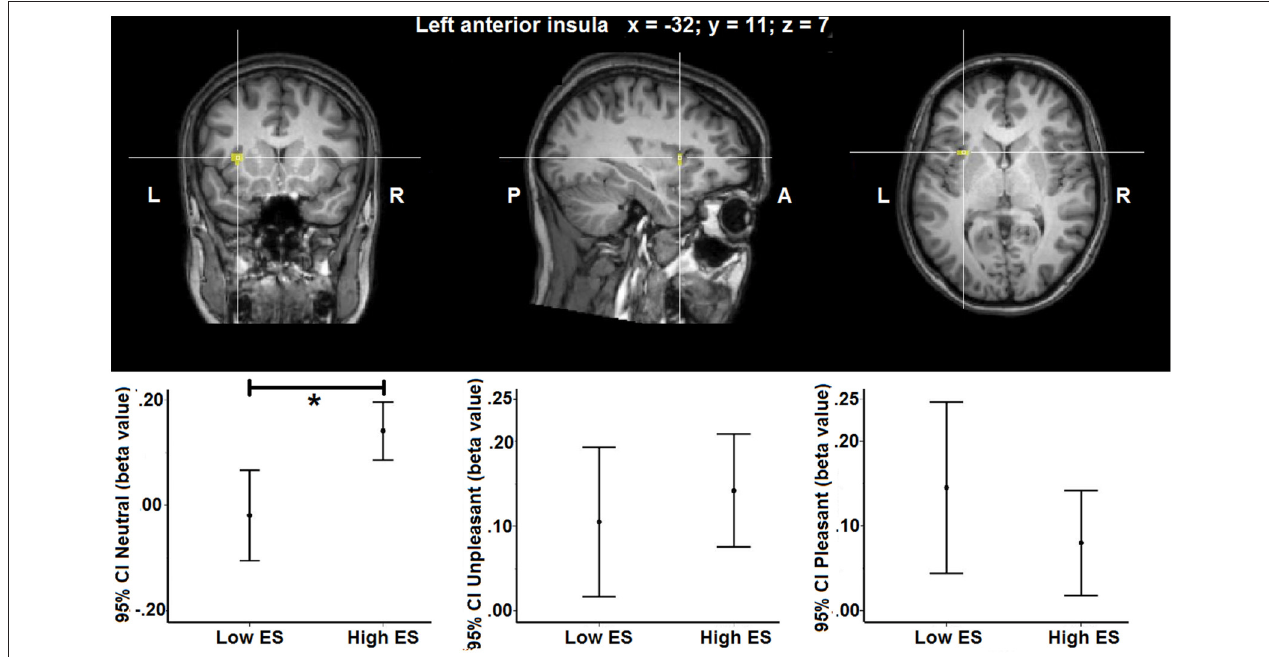
FIGURE 2 | Group statistical maps of the group (low ES, high ES) × experimental condition (unpleasant, pleasant, neutral) interaction effect showing a statistically significant cluster in left anterior insula [ F (2 , 46) > 10.44, p > 0.05 corrected]. Graphs show 95% Confidence Intervals (CI) of the beta values for each condition separated by ES group, compared to baseline. * significant effect of contrast at p < 0.05 based on post-hoc analysis.